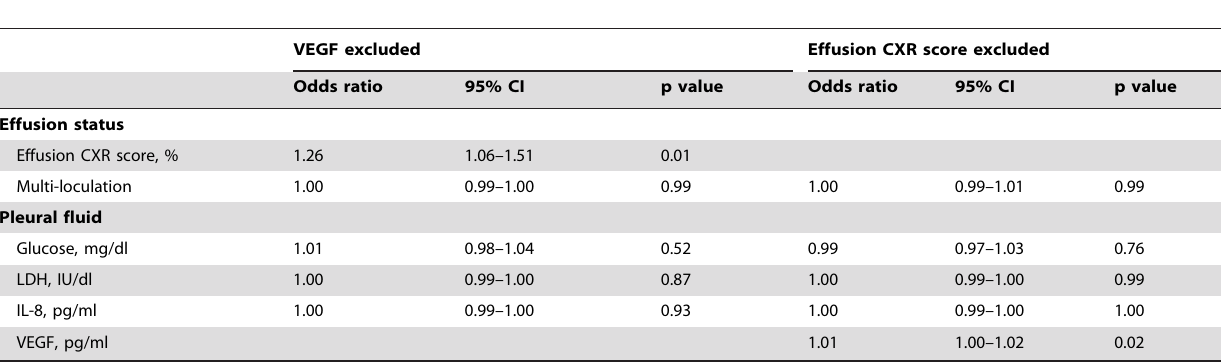
Table 6. Multivariate Logistic Regression Analyses of Factors Associated with Medical Treatment